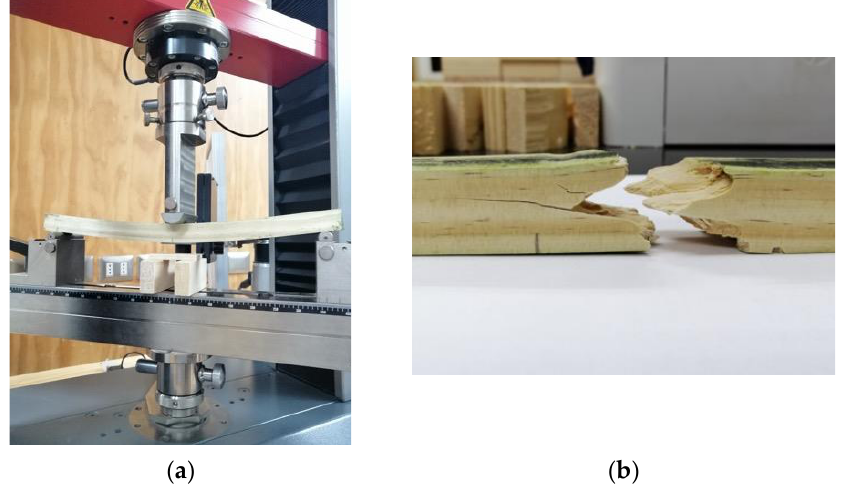
Figure 4. Photographs of the static bending test: ( a ) load applied to an impregnated wood sample by the Zwick/Roell Z020 universal testing machine and ( b ) failure generated in the specimen after the test was completed.